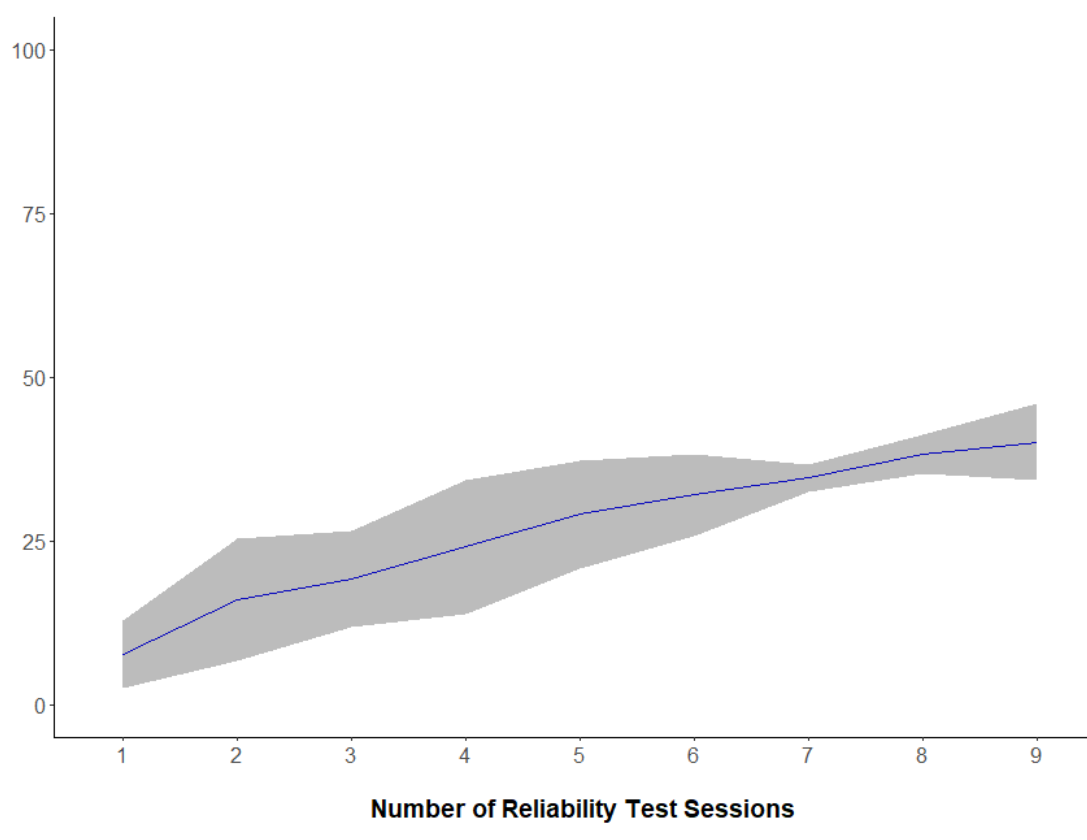
Figure 2. The percent of ethogram behaviors encountered by volunteer observers during successive inter-observer reliability test sessions of six study species monitored as part of a zoo-wide behavior monitoring program. The median percent of ethograms evaluated is depicted as a blue line with 1 median absolute deviation (MAD) above and below the median shown in the grey band. One observer that required 11 sessions to pass reliability testing is not shown.